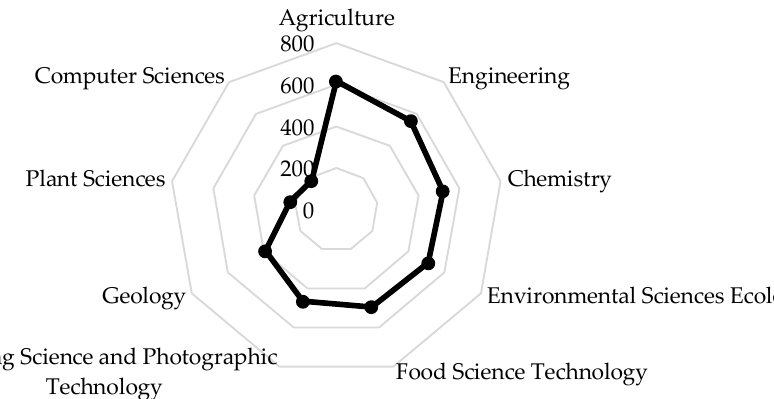
Figure 2. Fields covered in the literature of rice remote sensing research in 1980 – 2021.